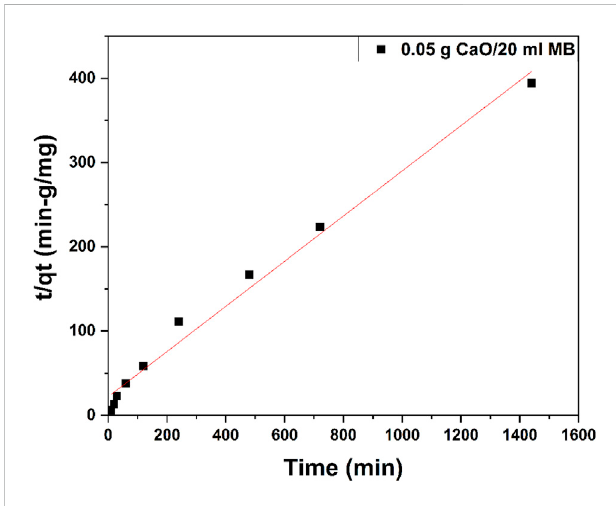
FIGURE 17 Second-order kinetic model plot of 0.05 g/20 ml MB concentrations.